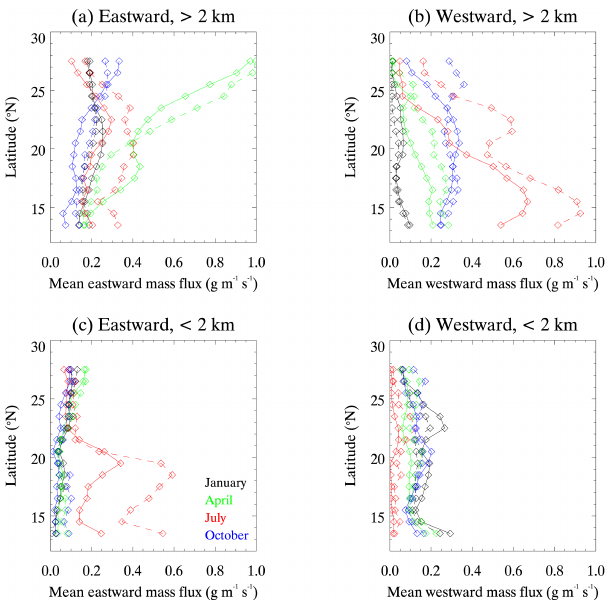
Figure 5. Monthly mean dust mass transport by 1 ◦ latitude band in the Red Sea, integrated over segments of the atmospheric column. Colours represent individual months, the solid lines represent 2007, and the dashed lines represent 2009. Panel (a) indicates eastward dust flux, from Africa, at 2–15km altitude; (b) westward dust flux, from the Arabian Peninsula, 2–15km; (c) eastward dust flux, 0– 2km altitude; (d) westward dust flux,